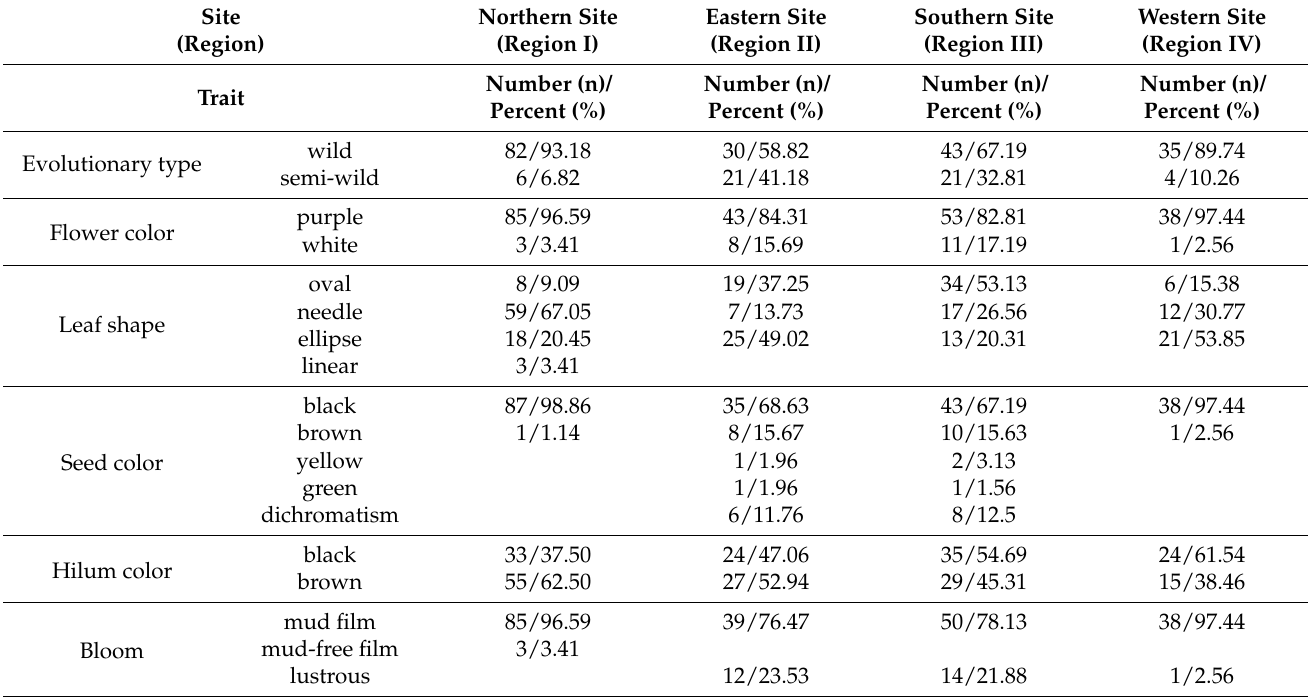
Table 3. Summary of 6 qualitative traits of 242 wild soybean samples based on four collecting